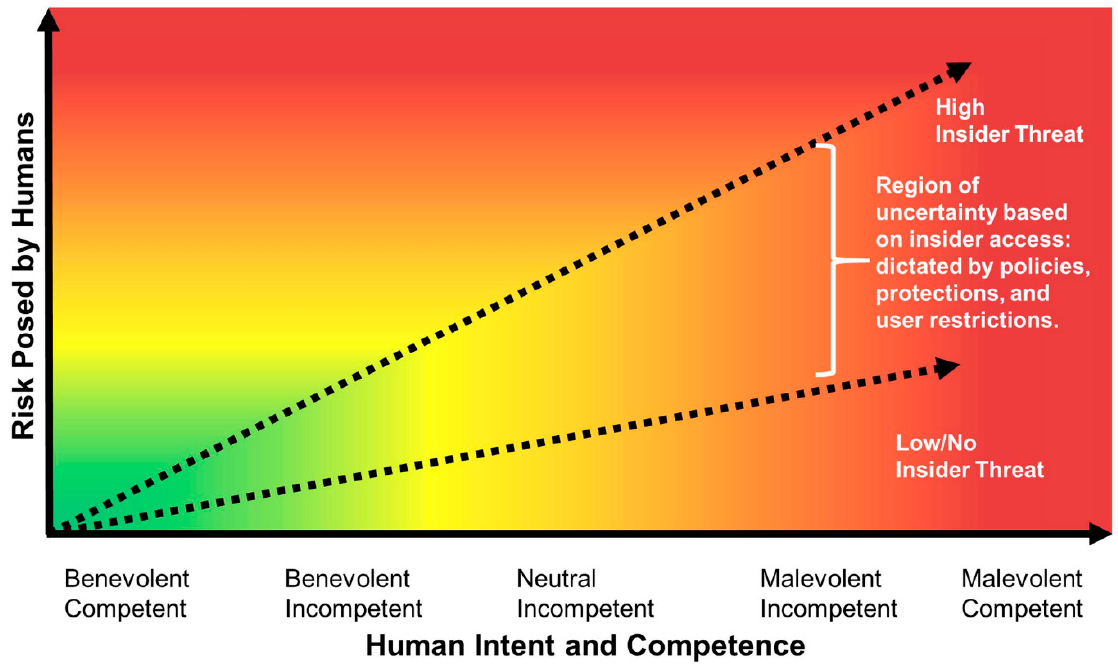
Figure 6. Representation of cyber security risks posed by humans considering the benign or malicious intent and the level of computational competence [57].